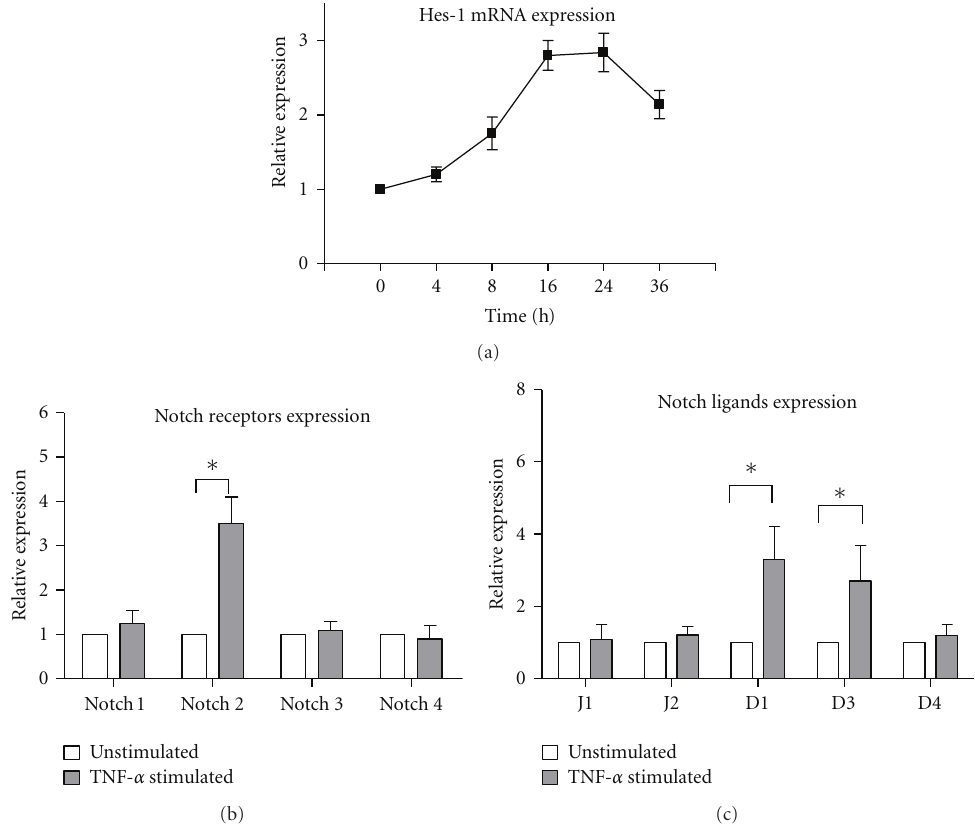
Figure 1: TNF- α stimulation induces the mRNA expression of Notch signaling molecules in fibroblast-like synoviocytes (FLS) from RA. (a) FLSs from 4 RA patients were cultured in the presence of TNF- α (10ng/mL) for 0, 4, 8, 16, 24, or 36 h, and then analyzed for Hes-1 expression by PCR; (b) FLSs from 4 RA patients were cultured in the presence of TNF- α (10ng/mL) for 24h, followed by analysis of Notch receptors expression by PCR; (c) FLSs from 4 RA patients were cultured in the presence of TNF- α (10ng/mL) for 24h, and then analyzed for Notch ligands expression by PCR; J1: Jagged 1; J2: Jagged 2; D1: Delta-like 1; D3: Delta-like 3; D4: Delta-like 4. Results were normalized to unstimulated condition (basal value = 1). Each column is the mean ± SD. ∗ P < 0 . 05 for unstimulated group versus TNF- α -stimulated